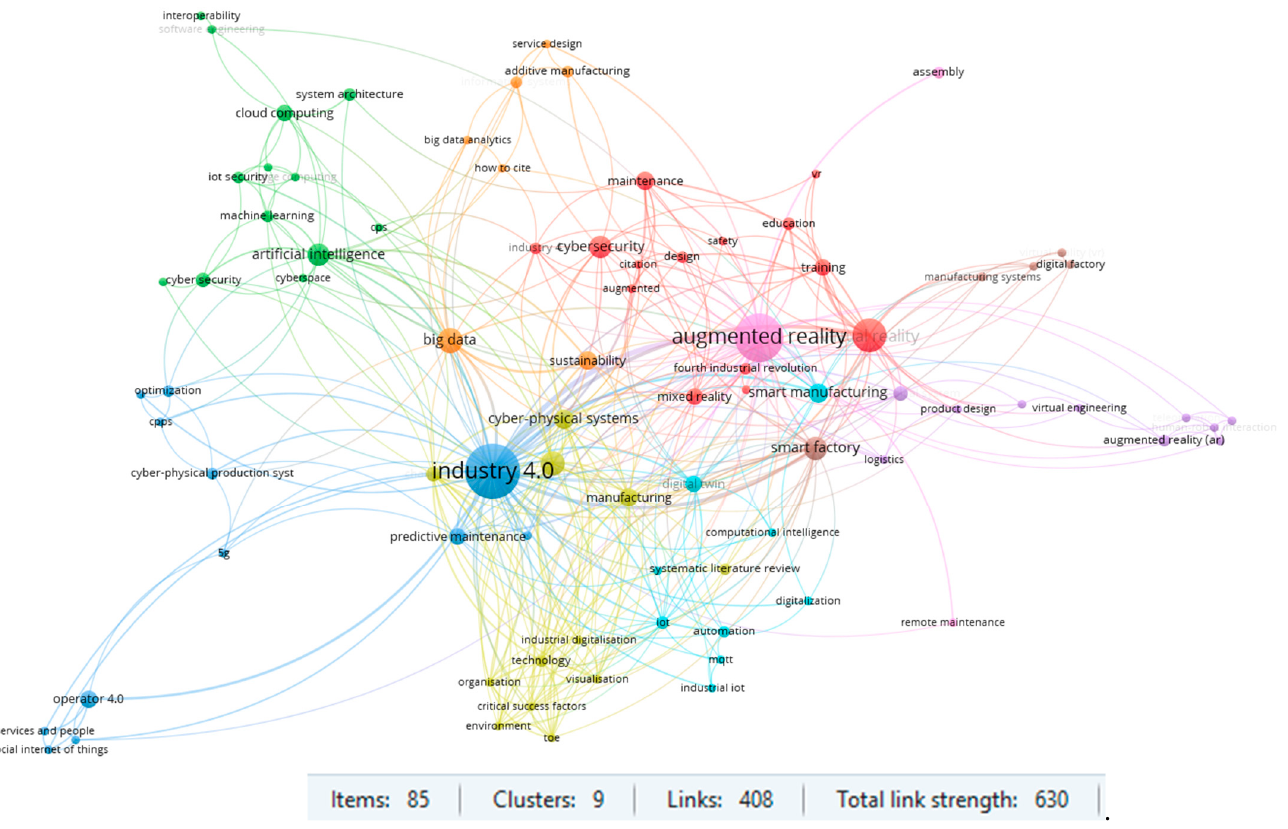
Figure 22. A number of the most frequently occurring keywords in the analyzed papers. Source: own development using VOSviewer software [101]